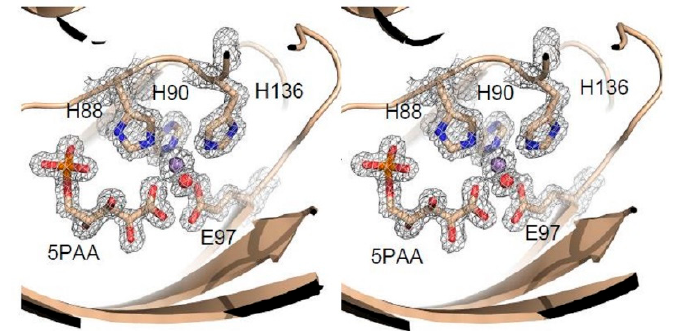
Figure 5. A stereo representation of the mF O –DF C electron density (grey mesh), contoured at 1.5 σ , for the P132A, Y133G mutant PfPGI structure (mutant AG, PDB code: 4LUK), showing the manganese (purple sphere), coordinating water (red sphere), 5PAA and metal coordinating residues (sticks).